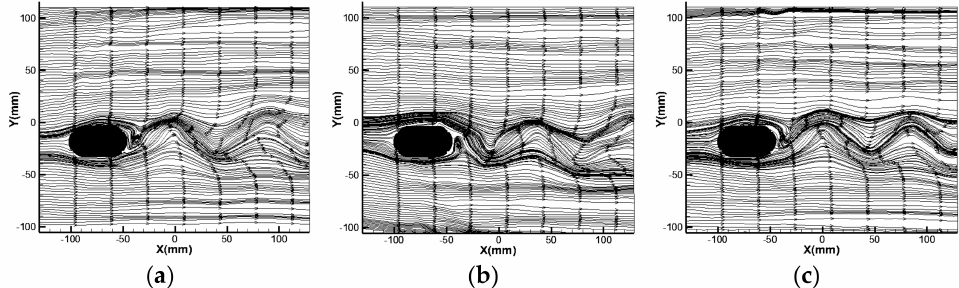
Figure 7. Instantaneous surface flow diagram of the flow around a single circular ended pier with